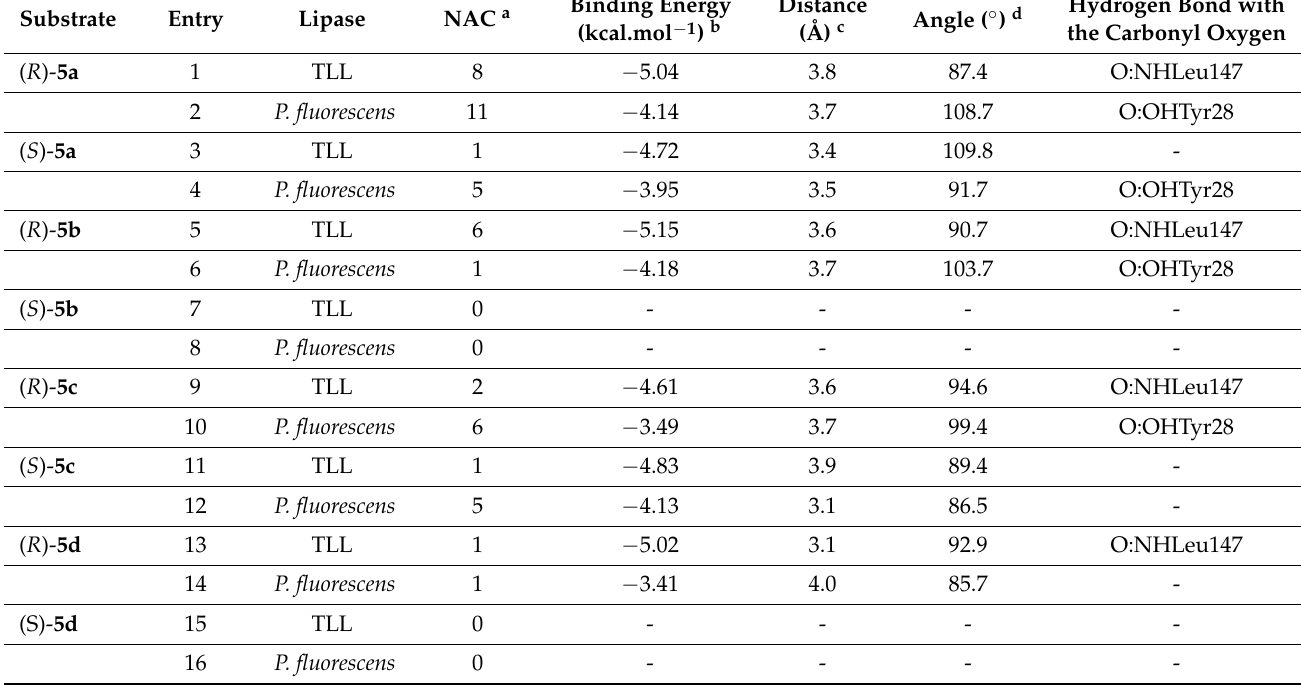
Table 6. Results from the molecular docking simulations of the complex